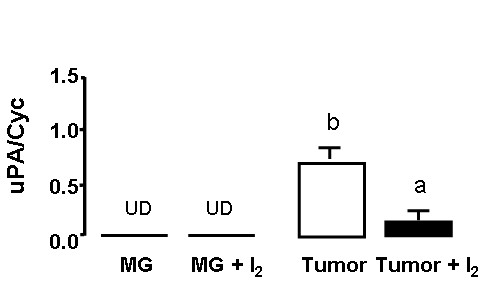
Urokinase Plasminogen Activator (uPA) expression. uPA mRNA in normal (MG) or tumoral (tumor) mammary glands from control or I2-treated rats were measured by the real time PCR method, and Cyclophilin (Cyc) served as internal control. UD, undetectable levels. Data are expressed as the mean ± SD. Differences between experimental groups were analyzed using a one-way ANOVA and the Tukey-HSD Test. Means with different letters are significantly different (p < 0.05)